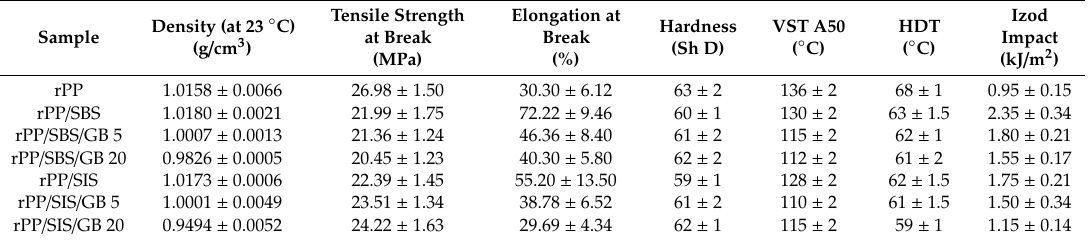
Table 6. Mechanical tests for post-consumer rPP/SBS, rPP/SIS, rPP/SBS/GB, rPP/SIS/GB composites compared with those for post-consumer rPP.